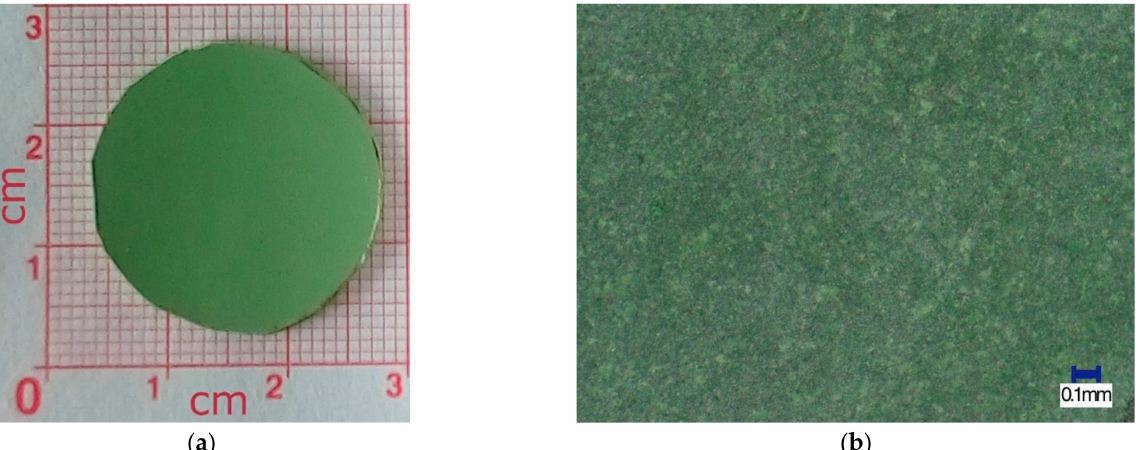
Figure 3. ( a ) Photo of sintered NiO–5CBCY sample; ( b ) optical image of the NiO–5CBCY surface on the sintered cylindrical